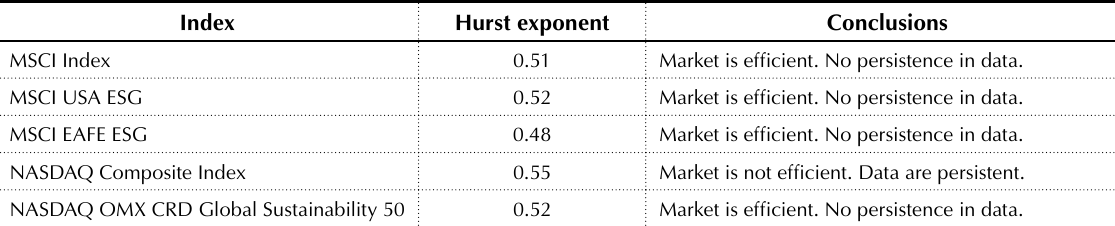
Table 5. Overall results of the Hurst exponent calculations for the MSCI ESG Indices, NASDAQ OMX CRD Global Sustainability Index and their traditional analogues (MSCI Index and NASDAQ